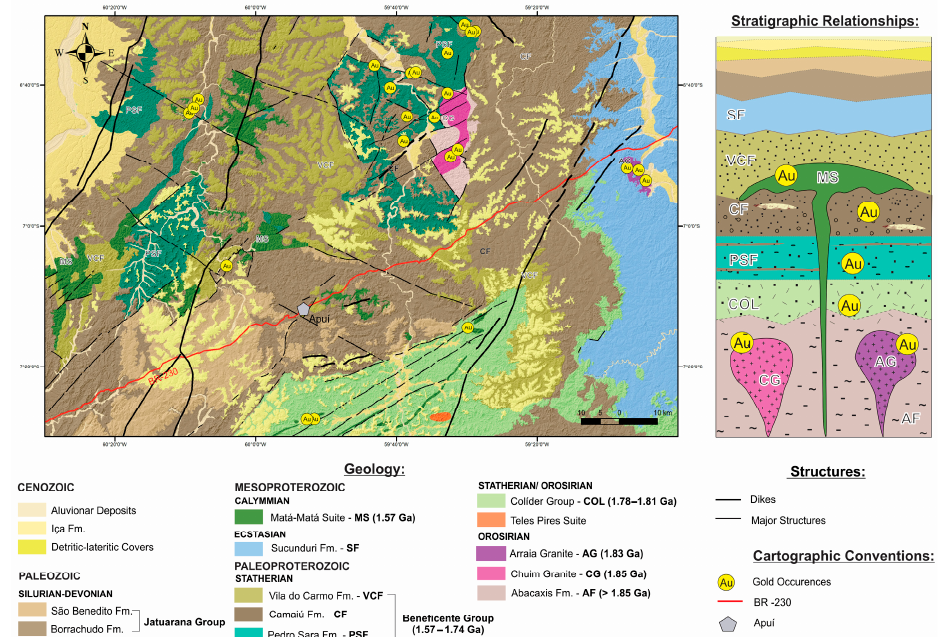
Figure 2. Juma District geological map with the location of gold occurrences, major regional structures, and the main road (BR-230). The stratigraphic relationships section illustrates that gold occurrences are associated with Orosirian to Mesoproterozoic rocks (modified from Meloni et al. [18]). Abbreviation: Fm.—formation.